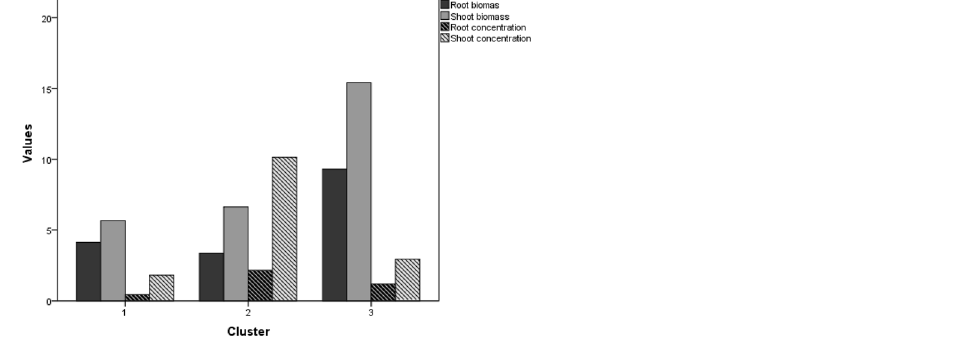
Figure 6. The K-means clustering analysis, with three